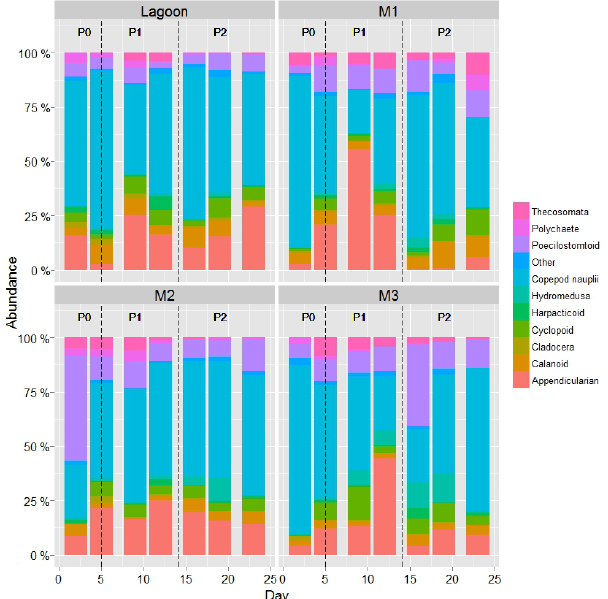
Figure 4. Zooplankton community NMDS ordination scores (di- mension 1 above and dimension 2 below), based on Bray–Curtis similarity of fourth root transformed abundance data, over the 23- day VAHINE experiment (13 January–4 February 2013) for the three VAHINE mesocosms (M1–3) and the lagoon waters. P0, P1, and P2 refer to the pre-phosphorous fertilization, DDA-dominated, and UCYN-C-dominated periods of the experiment, respectively.